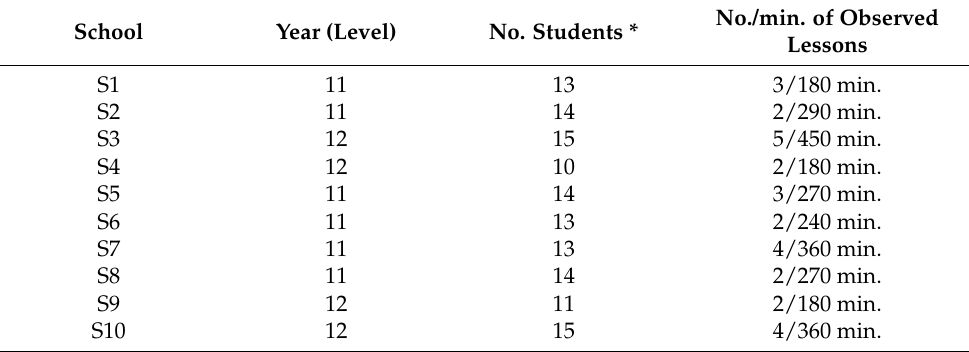
Table 1. A table representing the participating